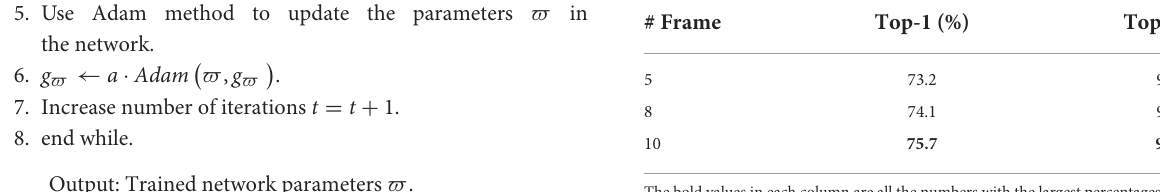
TABLE 3 Experimental results obtained using video frames of different timing lengths as